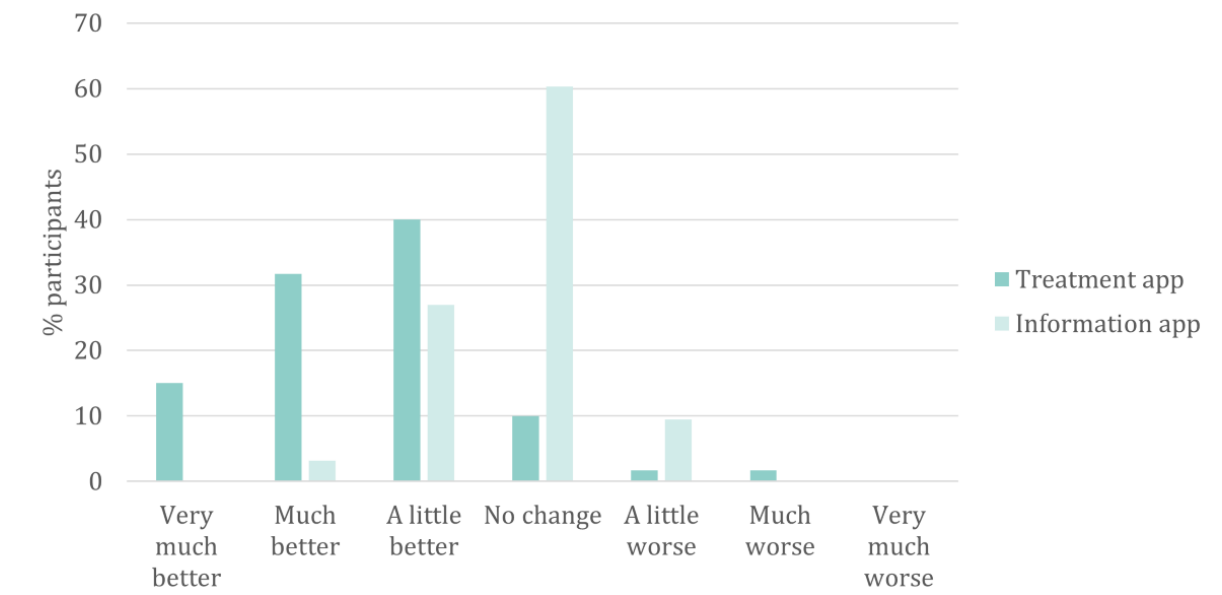
Figure 3. Patient’s Global Impression of Improvement responses reported by the participants at follow-up. Comparison between the treatment group (n=60) and the information group (n=63). * P <.001 (Mann-Whitney U test). Two participants were lost to follow-up in the treatment group and imputed as “no change” for this